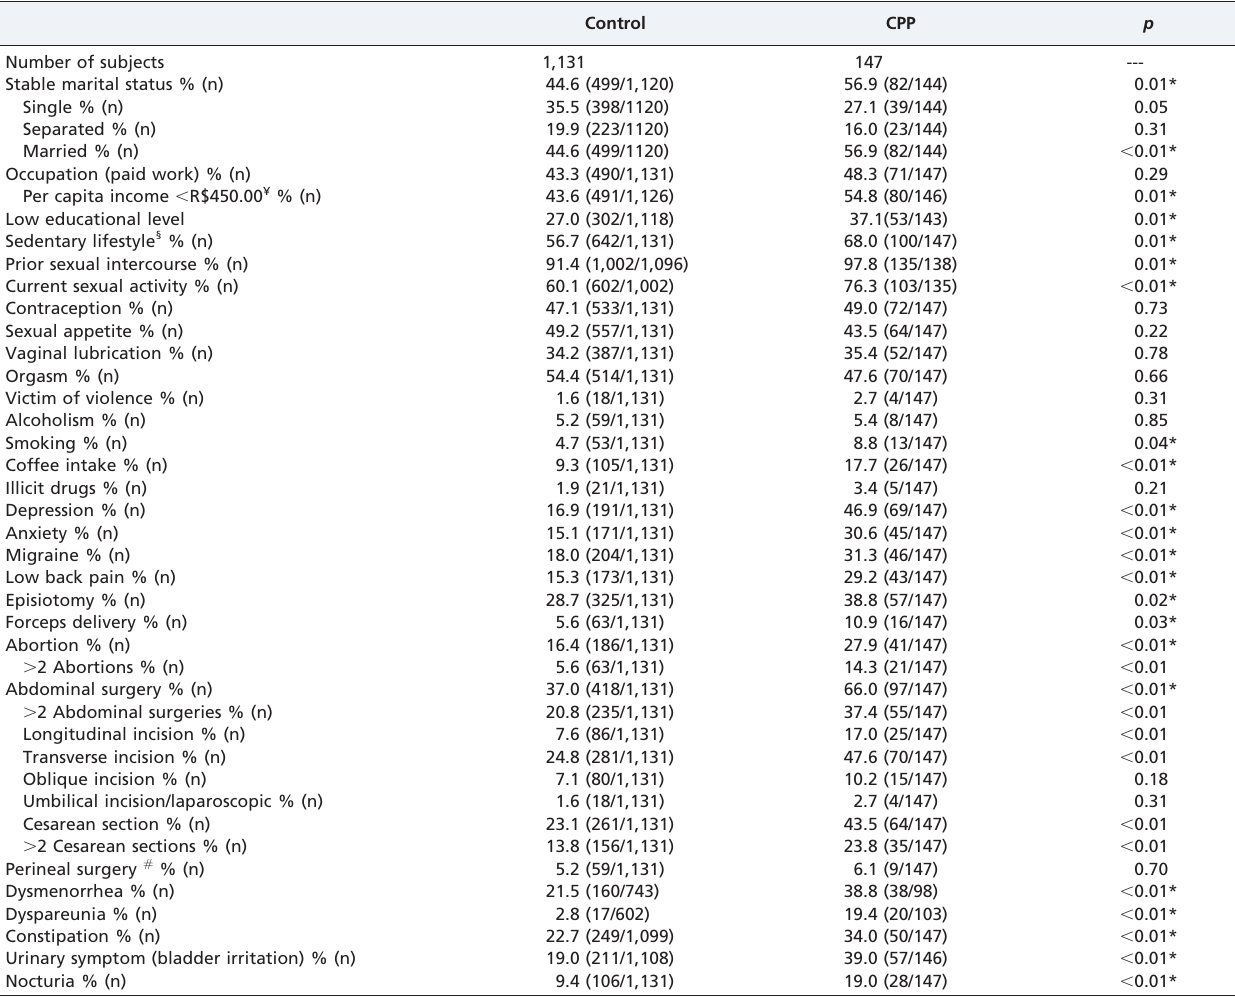
Table 2 - Variables related to chronic pelvic pain (univariate analysis).